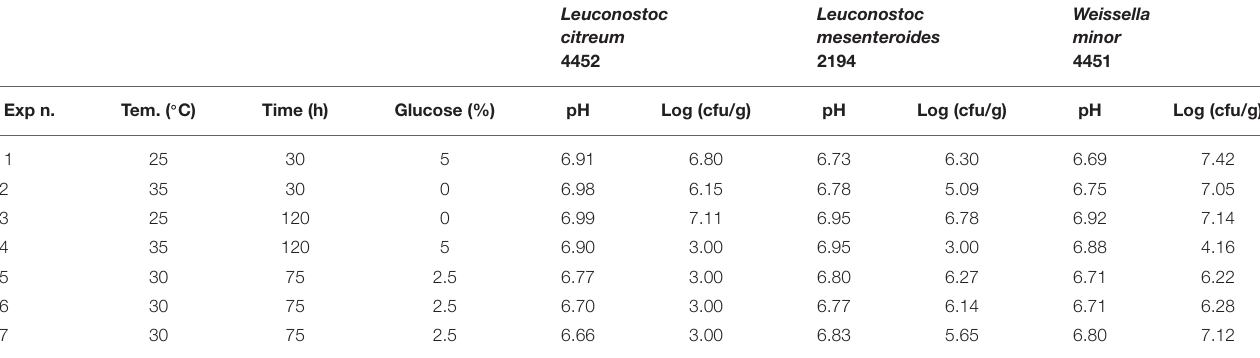
TABLE 2 | Experimental condition for microorganisms with an optimum at 30 ◦ C in vanilla without seeds.